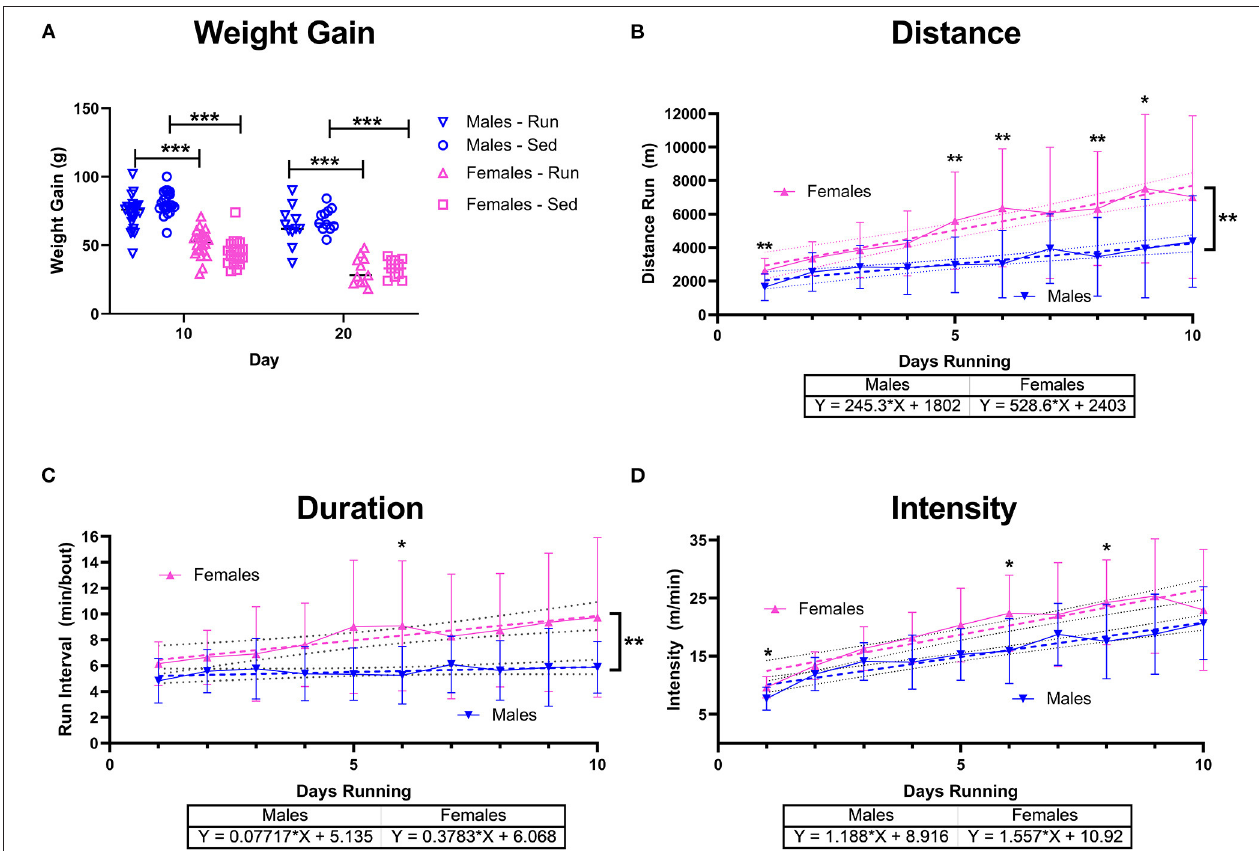
FIGURE 5 | Sex Differences with Running. Male (blue) and female (pink) rats were placed in a locked or functional running wheel for 10 days to determine acute effects of exercise ( n = 14/sex). A 2nd cohort of rats were placed in a functional or locked running wheel for 10 days then rested in their homecage for an additional 10 days ( n = 14/sex). (A) Weight gain at the 10 day and 20 day time points were measured. (B) Distance run was calculated daily and across 10 days of running. (C) Duration of running periods and (D) intensity of running was also calculated daily. Data are presented as average ± SD. A linear regression (dotted lines) was performed on each to determine change across time and compared between males and females and equation of line is provided. * p < 0.05, ** p < 0.01, *** p <